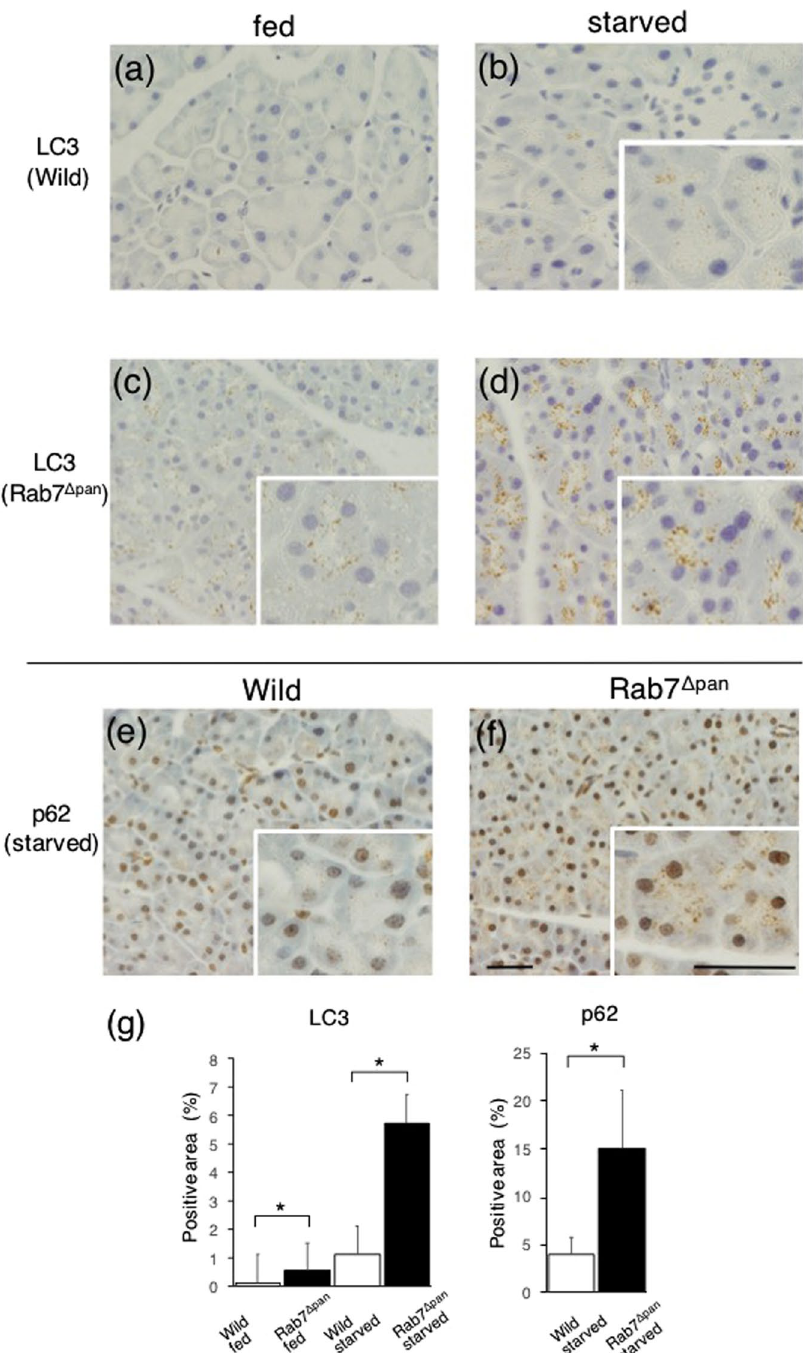
Figure 3. The increased expression of both LC3 and p62 in Rab7 Δ pan pancreas. IHC of LC3 ( a – d ) and p62 ( e , f ) was performed using wild ( a , b , e ) and Rab7 Δ pan ( c , d , f ) mouse pancreases. In panels ( b , d , e and f ), the specimens were prepared after 24-h starvation. Scale Bars: 20 µ m. ( g ) Quantification of the positive signals in images of immunohistochemistry images of LC3 (left panel) and p62 (right